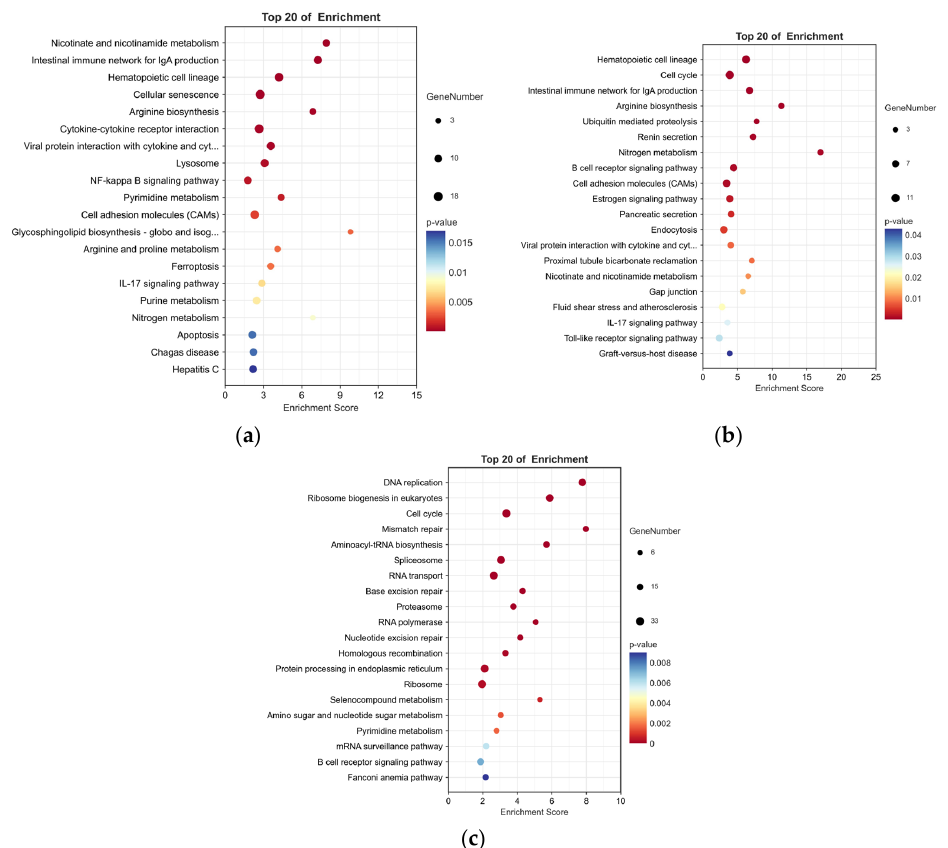
Figure 4. KEGG highly significant enrichment pathways of DEGs between two pairwise compari- sons. ( a ) Top 20 pathways enriched in upregulated DEGs between PS and BC groups. ( b ) Top 20 pathways enriched in downregulated DEGs between L-PS and PS groups. ( c ) Top 20 pathways enriched in downregulated DEGs between L and BC